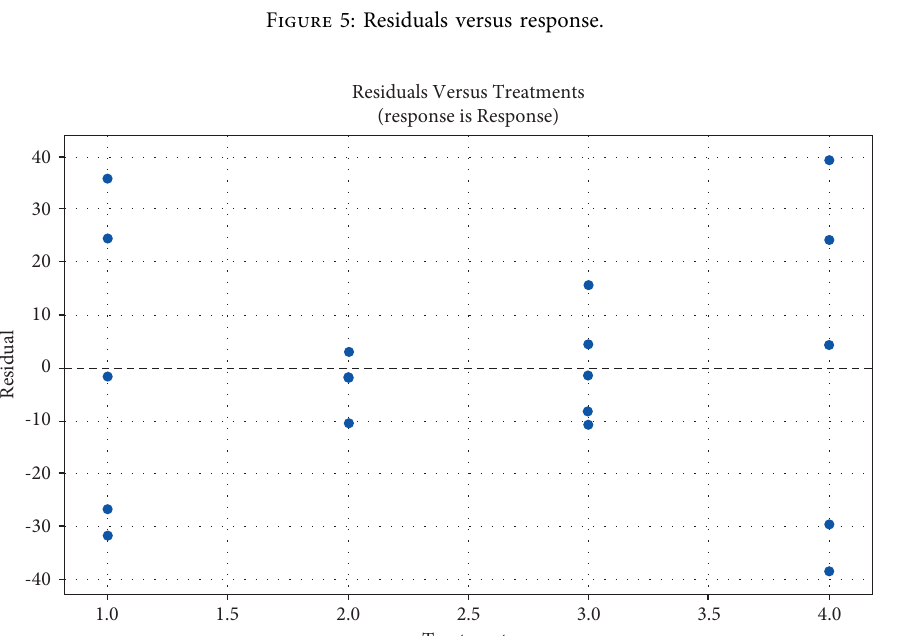
Figure 5: Residuals versus response.